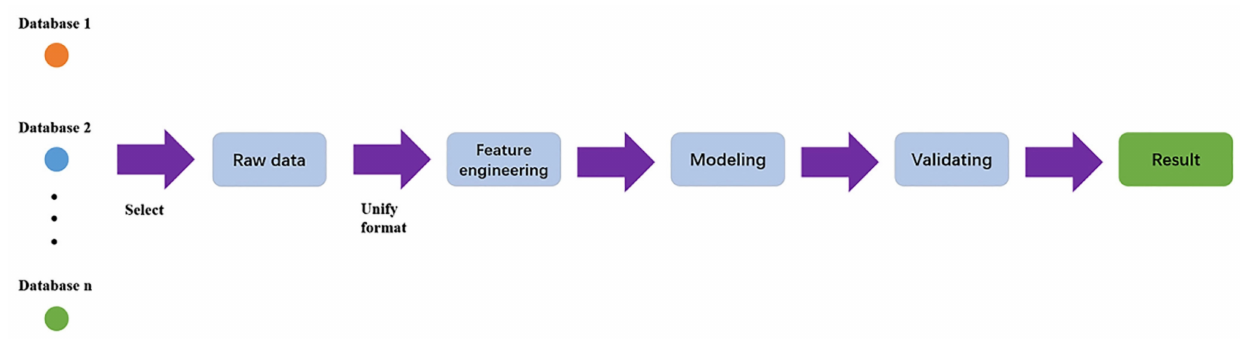
Figure 8. Machine learning workflow. Reproduced from [106], under the terms of the Creative Commons CC BY license [18]. No changes have been made.